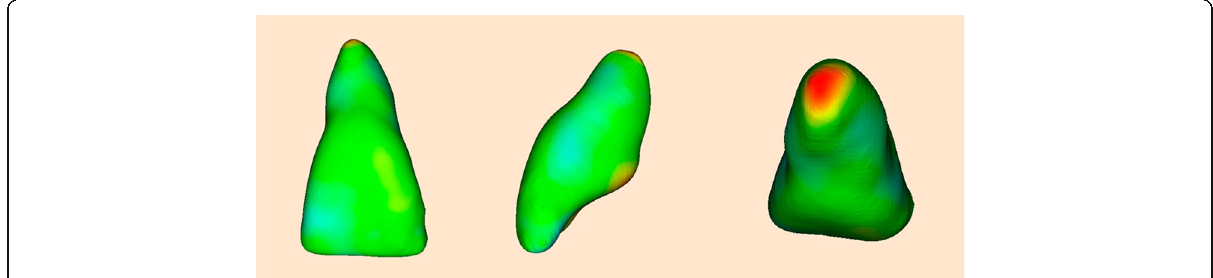
Fig. 5 Individual segmentation to create volumetric label maps using the root region at the enamel-cement junction level as the best fit